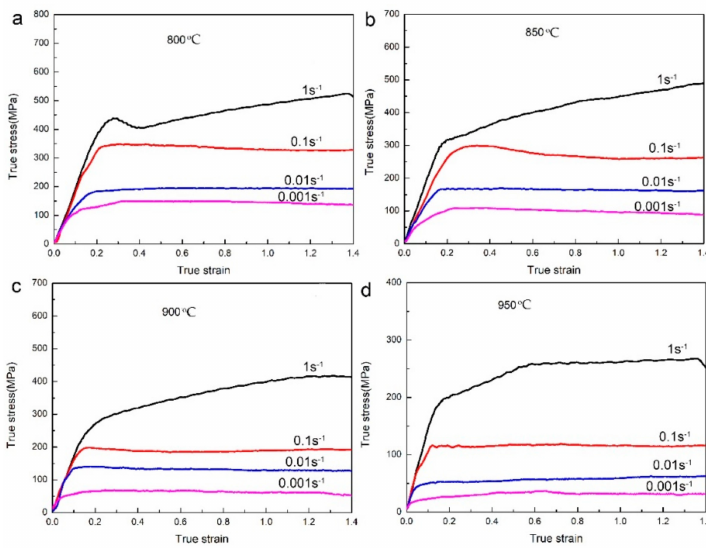
Figure 2. Stress-strain curves at various strain rates for 7.5 vol.% TiB w / near α -Ti composite: ( a ) 800 ◦